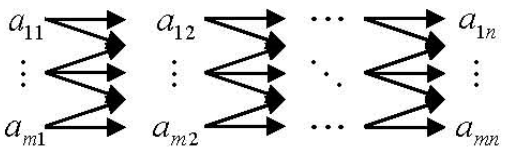
Figure 5. An assembly line with m × n workstations.